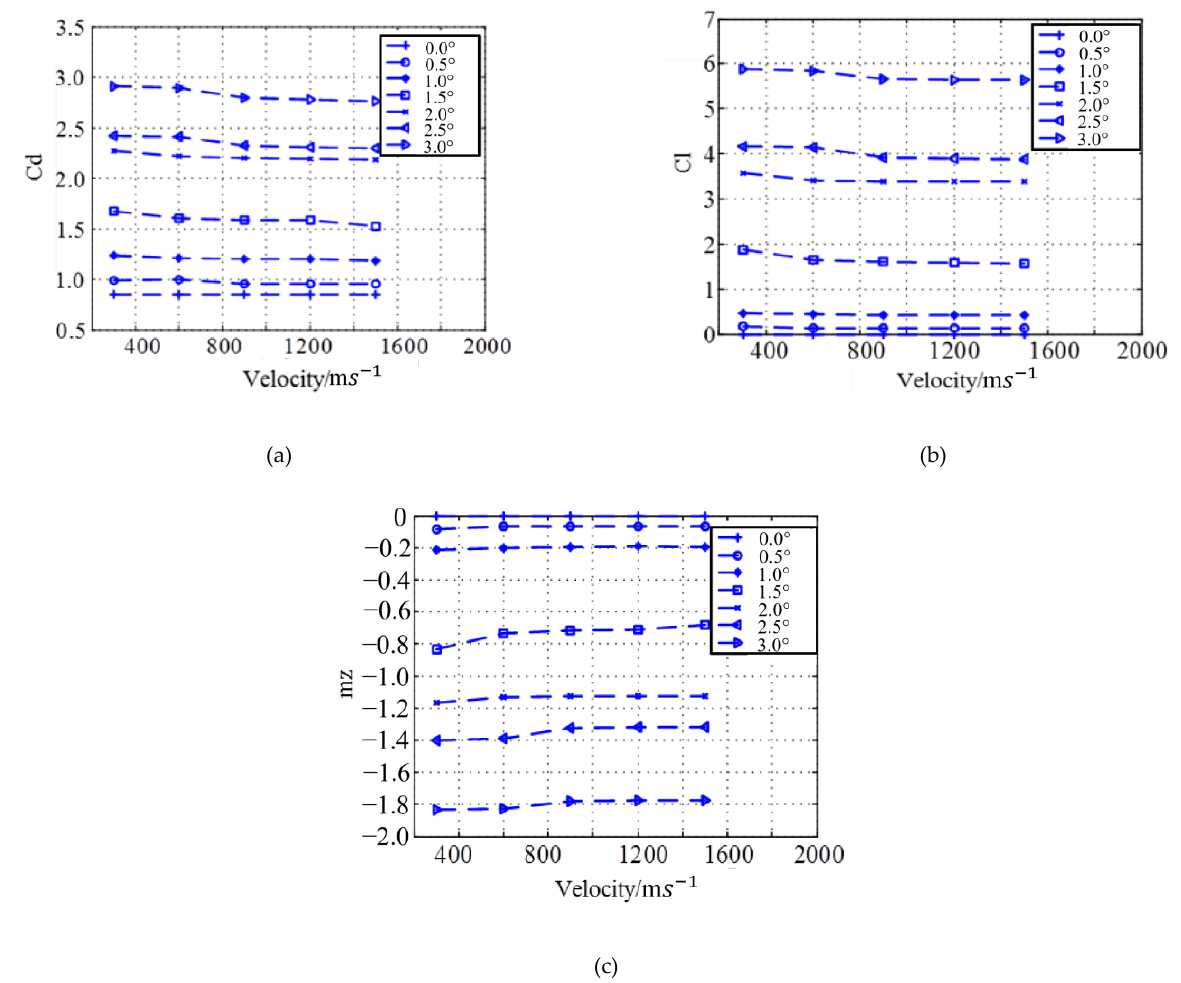
Figure 14. The influence of speed and attack angle on the fluid force coefficient, ( a ) drag coefficient, ( b ) lift coefficient, and ( c ) pitching moment coefficient.